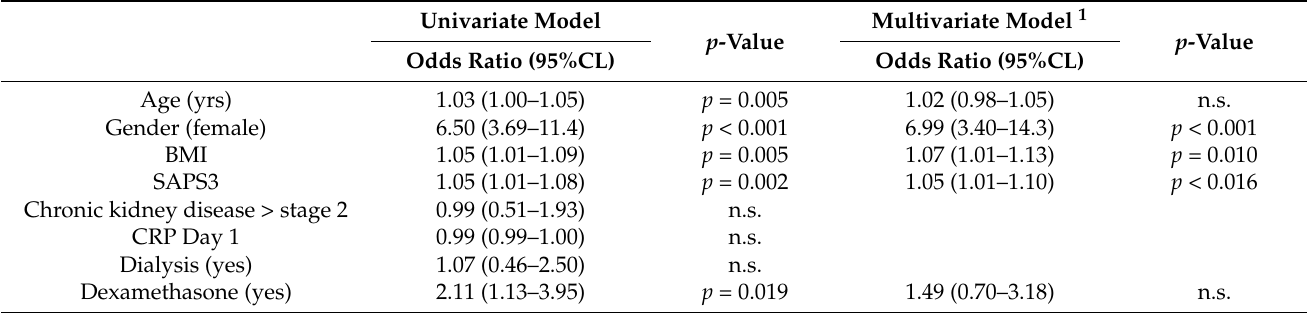
Table 1. Logistic regression models to predict the outcome. Univariate Model